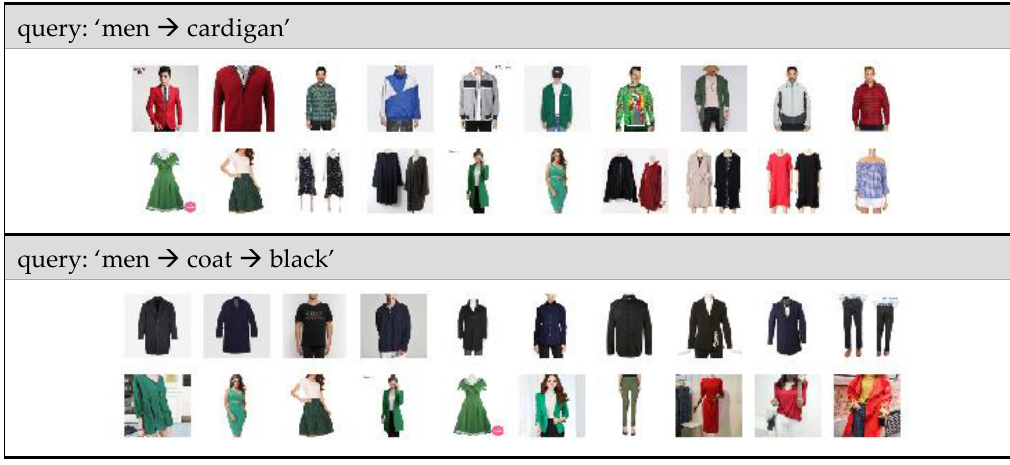
Figure 10. Fashion product search results for category-based queries.